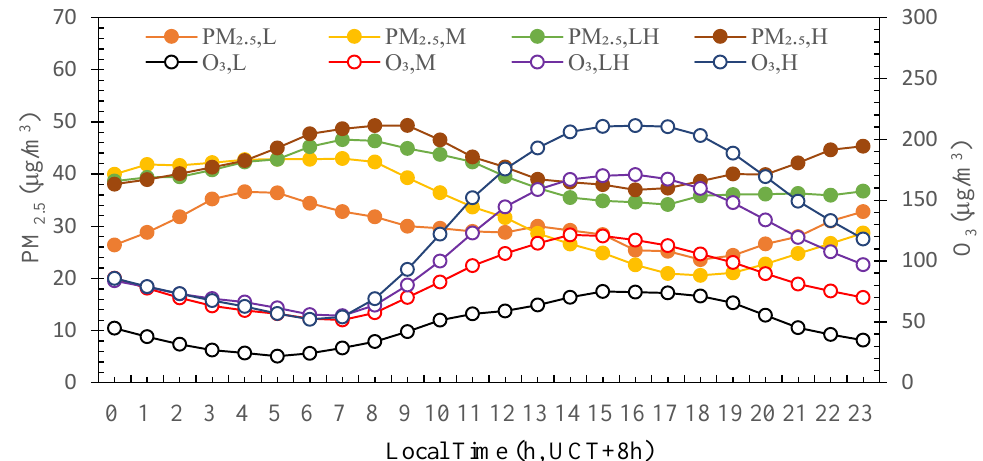
Figure 3. Diurnal variations in mean hourly concentrations of PM 2 . 5 and O 3 under different photochemical activities during the summertime 2020 in Tianjin, China.